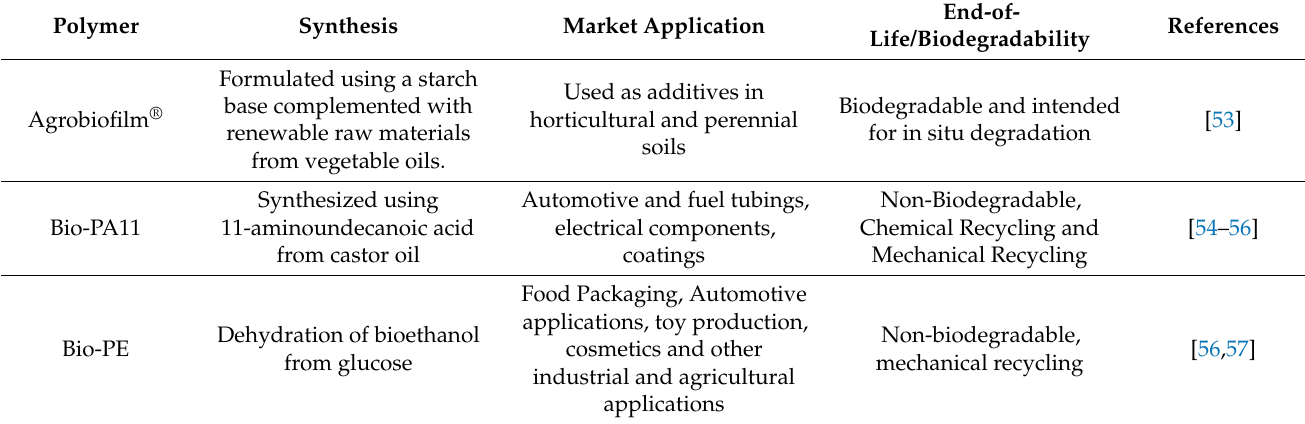
Table 1. Production, usage, and end-of-life options for commercially available (or soon to be available) biobased polymers.